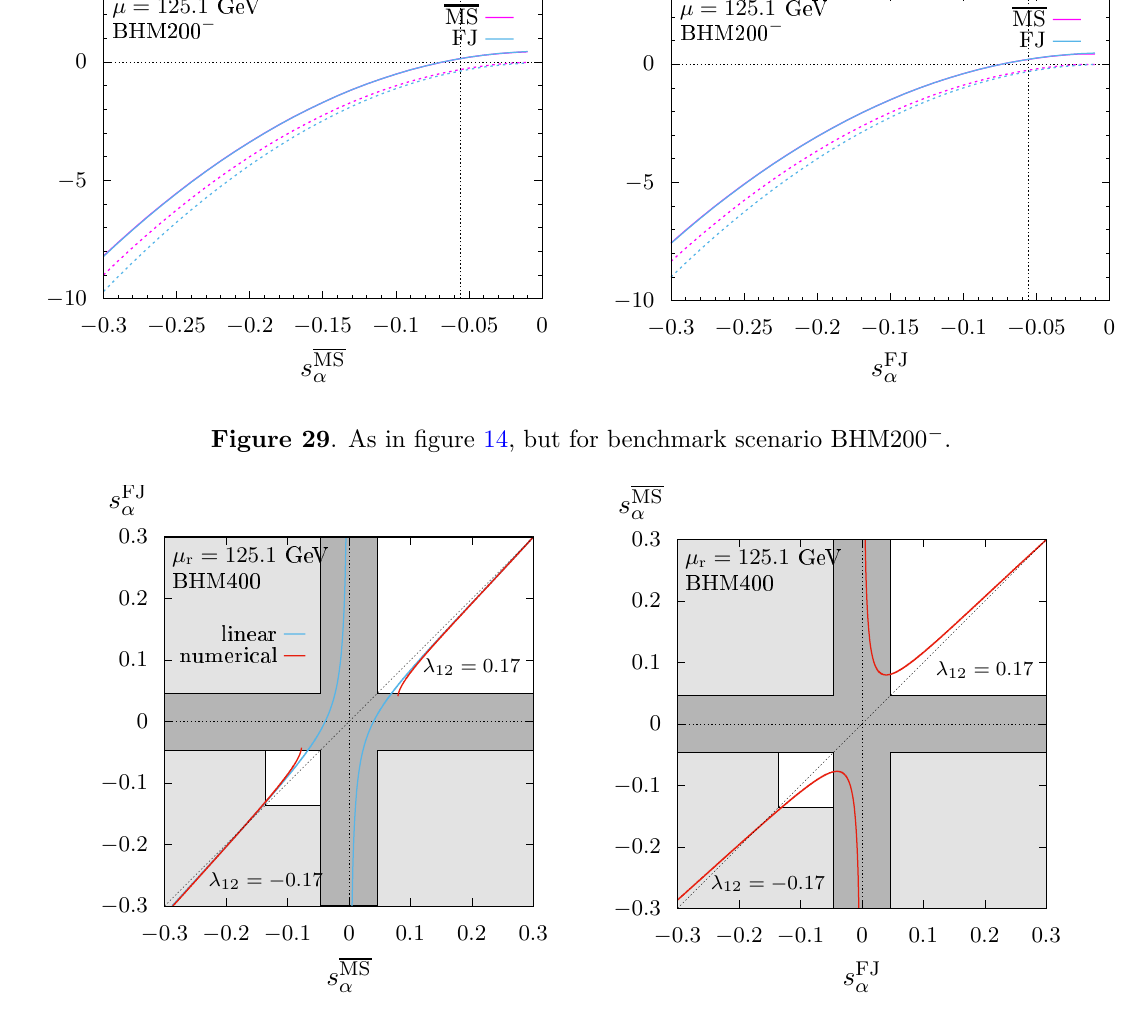
Figure 30 . As in (cid:12)gure 9, but for benchmark scenario